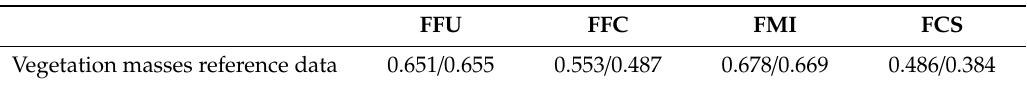
Table 2. Kappa / Cramer’s V of cross-tabulation combinations of vegetation areas detected and reference data confusion